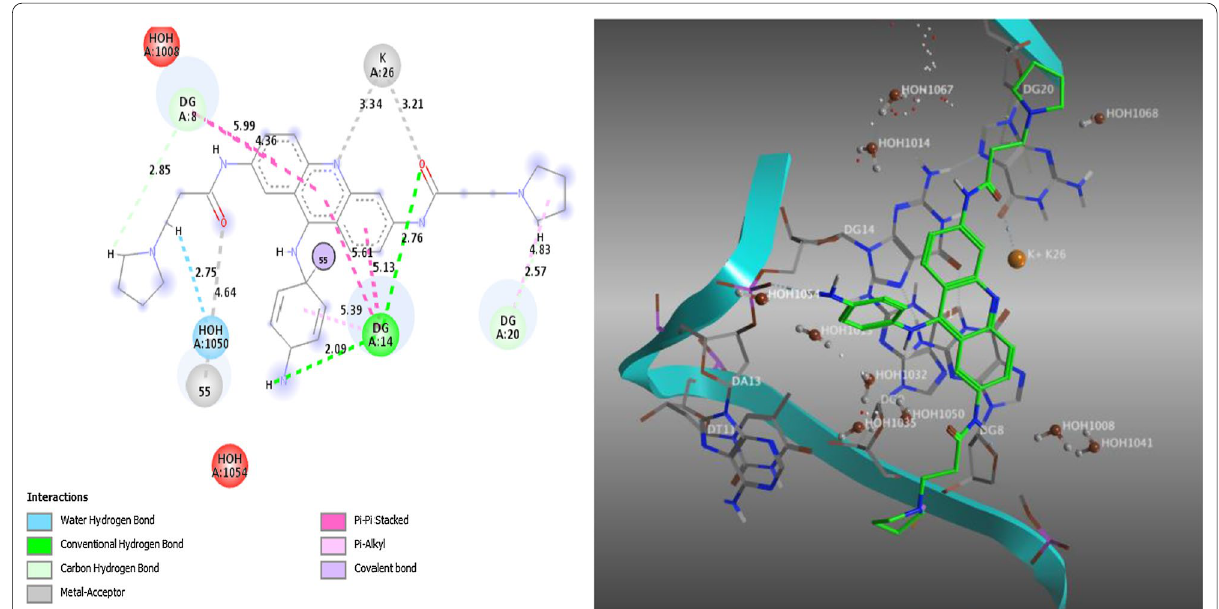
Fig. 17 Display of 2D and 3D interaction of compound 82 with human telomeric G-quadruplex DNA